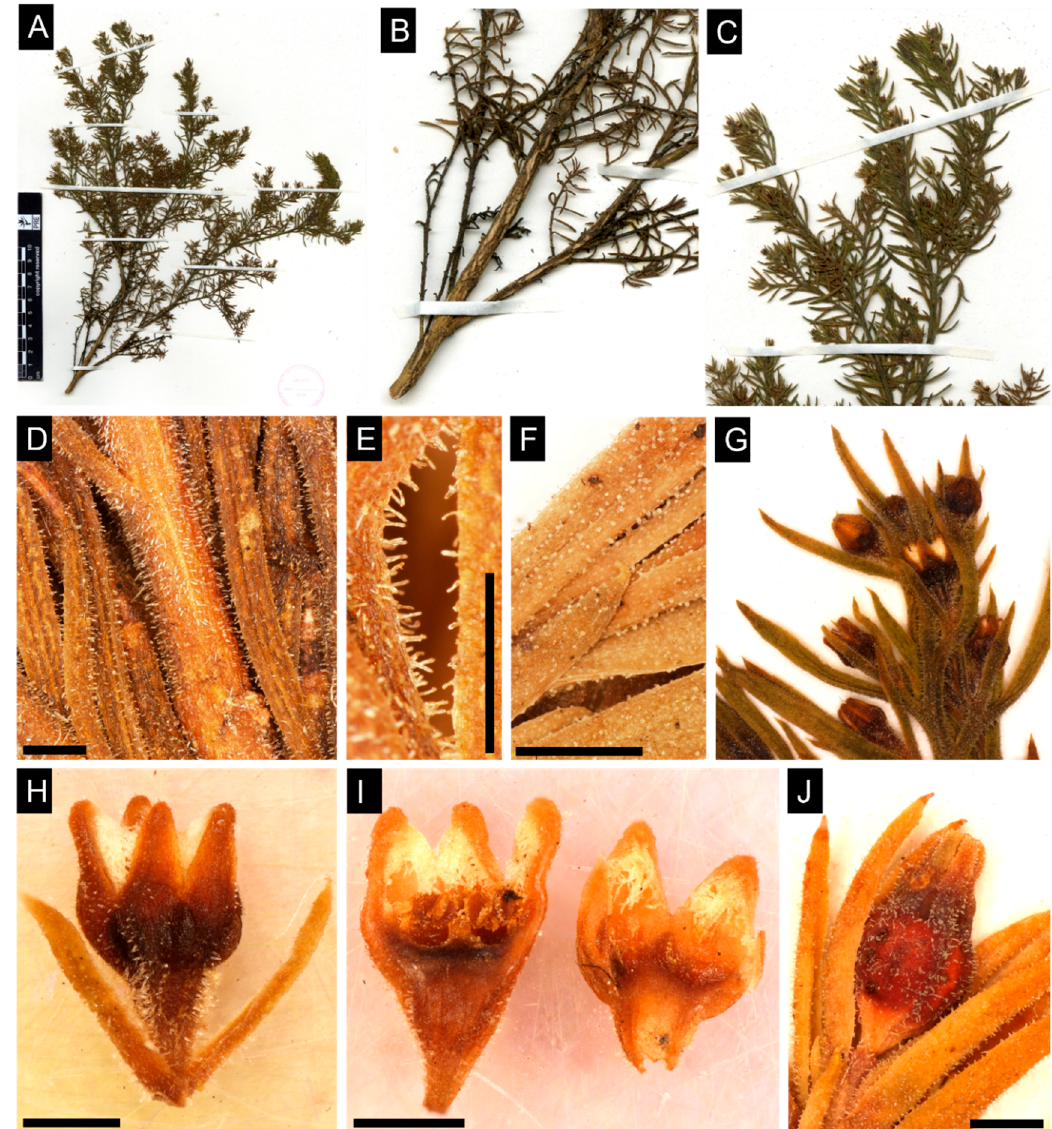
Figure 5. Thesium hispidifructum . ( A ) Habit. ( B ) Woody stem. ( C ) Branches. ( D ) Hispid branches and leaves. ( E , F ) Variation in the indumentum from hispidulous to hispid. ( G ) Compact spike-like inflorescence. ( H ) Exterior of a rehydrated flower with external “glands” and a hispidulous to hispid indumentum. ( I ) Cross-section of a rehydrated flower showing the anthers inserted at the base of the lobes and the stigma reaching to the bottom of the anthers. ( J ) Dry fruit with hispid indumentum. The scale bars represent 1 mm. Photographs taken by N. Lombard ( B – J ). Images © South African National Biodiversity Institute. Reproduced with the consent of the South African National Biodiversity Institute ( A – C ).